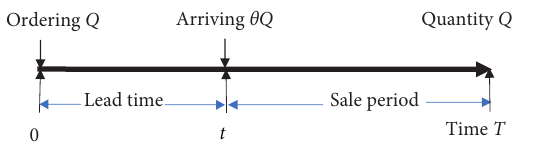
Figure 1: Model timeline without